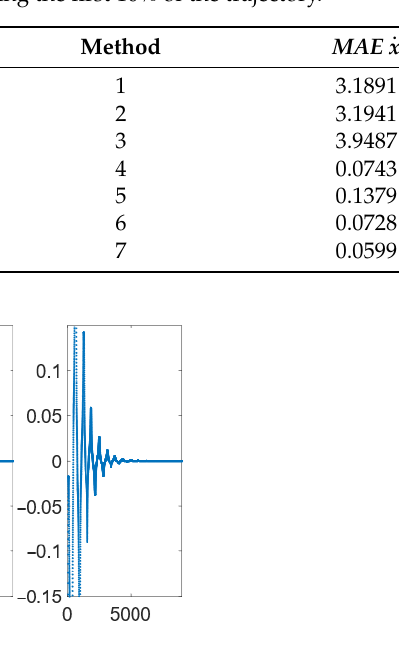
Table 2. Mean absolute error (MAE) when excluding the first 10% of the trajectory.